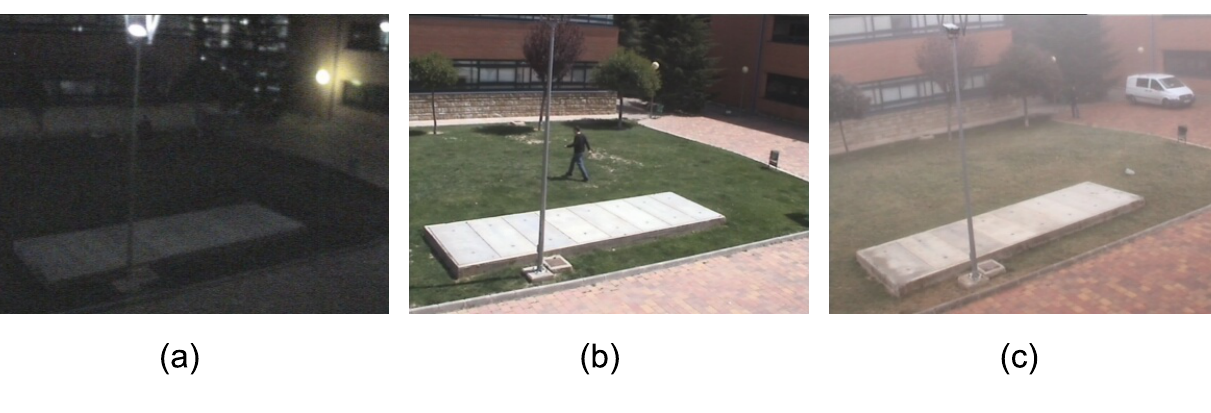
Figure 2. Different confidence values for the visible spectrum. ( a ) Visible-light image with a low confidence value in night conditions; ( b ) visible-light image with a high confidence value; ( c ) visible-light image with a low confidence value in fog